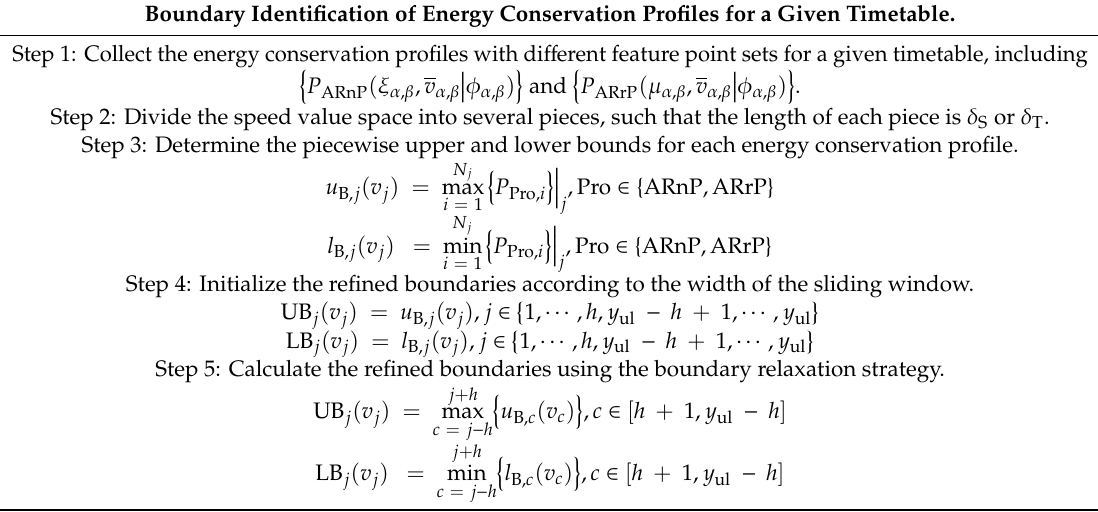
Table 1. Procedures of the boundary identification method.